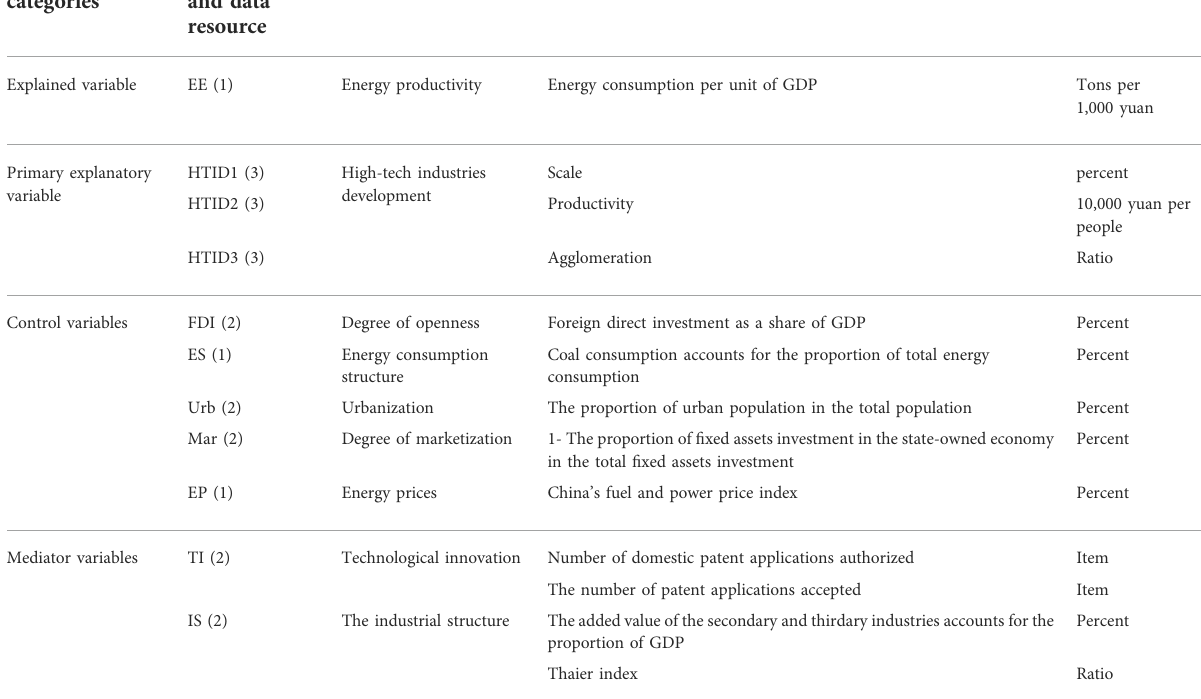
TABLE 1 Description and data resource of each